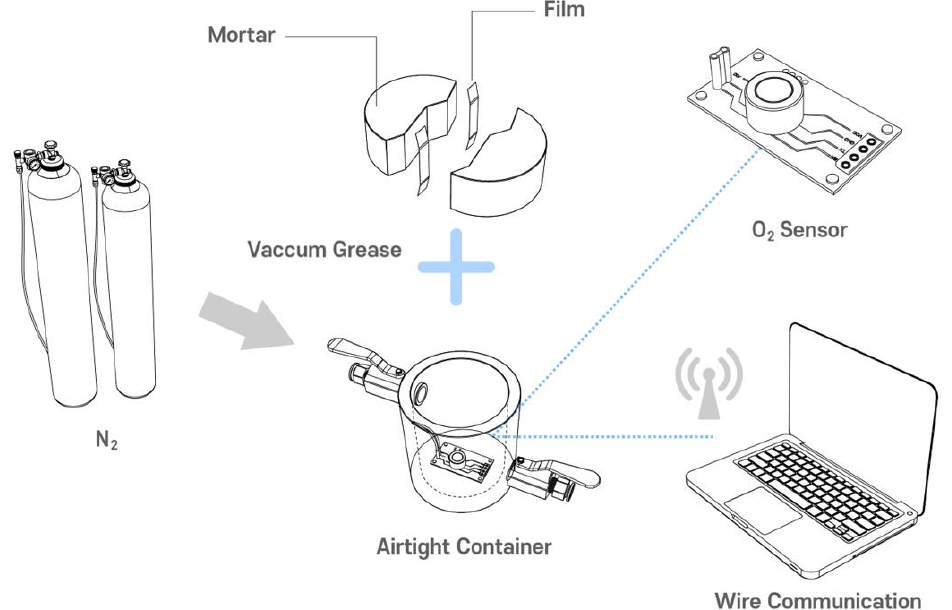
Figure 3. Overview of the experimental configuration and apparatus.